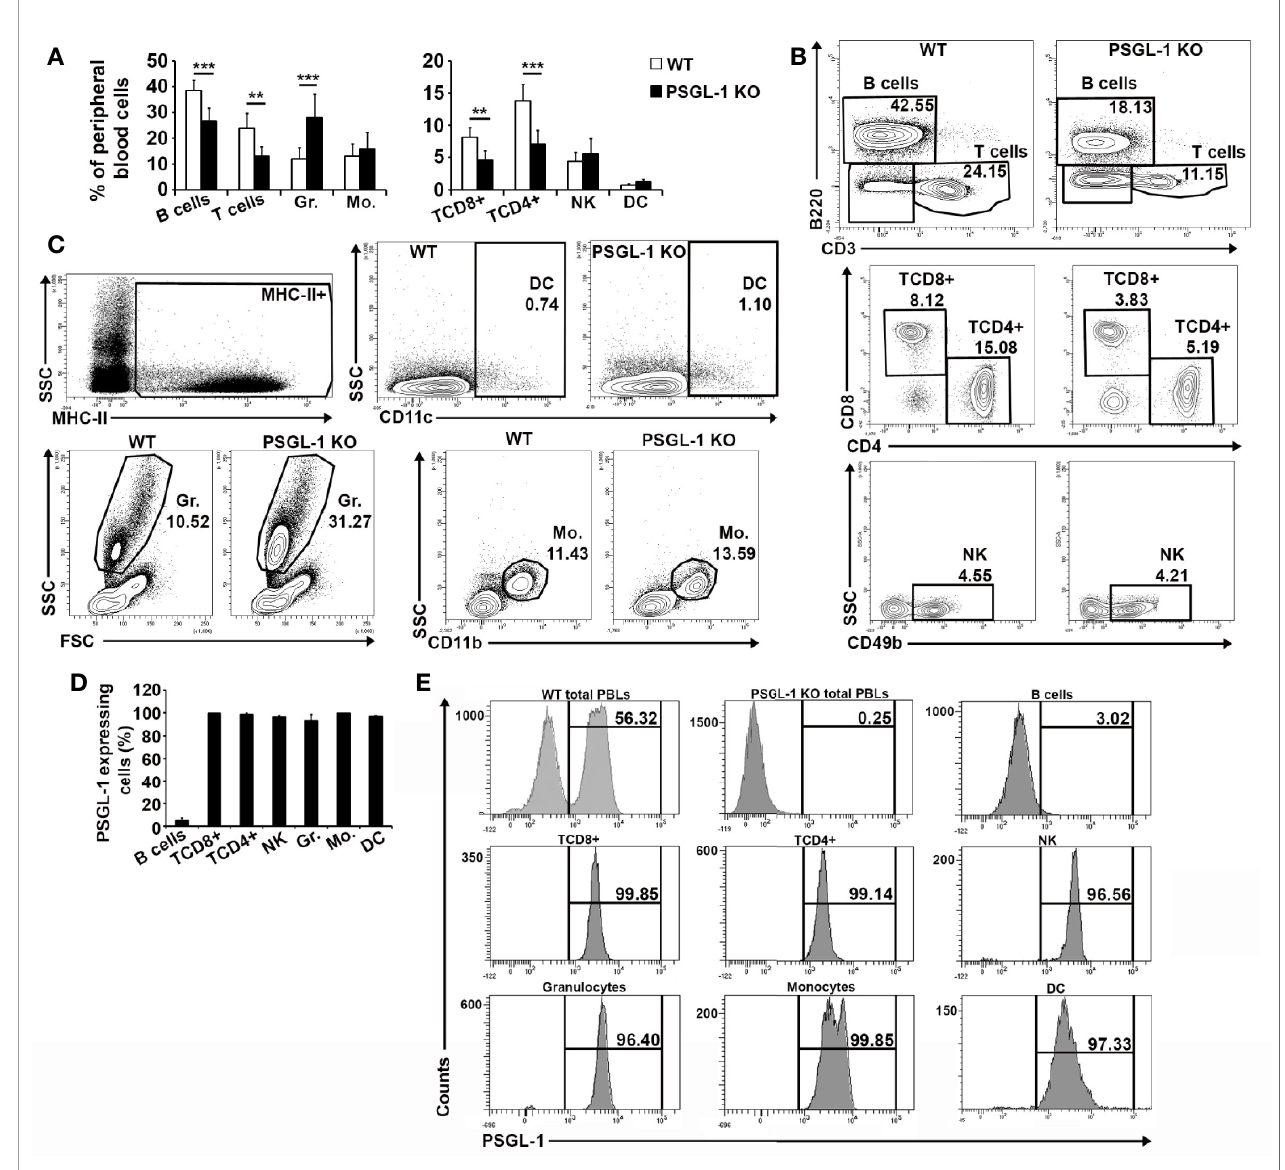
FIGURE 1 | Characterization of blood cell populations in PSGL-1 − / − mice and analysis of PSGL-1 expression in circulating cells. (A) Relative frequencies of the circulating immune cell populations in WT and PSGL-1 − / − mice. (B) Representative density plots for WT and PSGL-1 − / − mice showing gating strategy for B (B220 + ) and T cells (CD3 + ) (upper panels); CD4 + T cells (TCD4+) and CD8 + T cells (TCD8+) gated in the CD3 + population (middle panels); natural killer cells (NK) (CD49b + ) gated in the CD3 − B220 − double negative population (lower panels). (C) Representative dot/density plots for WT and PSGL-1 − / − mice showing gating strategy for: granulocytes (Gr.) identi fi ed by size and complexity; dendritic cells (DC) (CD11c + MHC-II + ); and monocytes (Mo.) (CD11b + ) of WT and PSGL-1 − / − mice. (D) Percentage of PSGL-1 expressing cells among the different circulating immune populations of WT mice. (E) Representative histograms showing PSGL-1 expression in the above-mentioned circulating immune cell populations. Bars represent the mean+standard deviation. **p < 0.01, ***p < 0.001 analyzed by Student ’ s t test. In all cases, n = 6 mice per